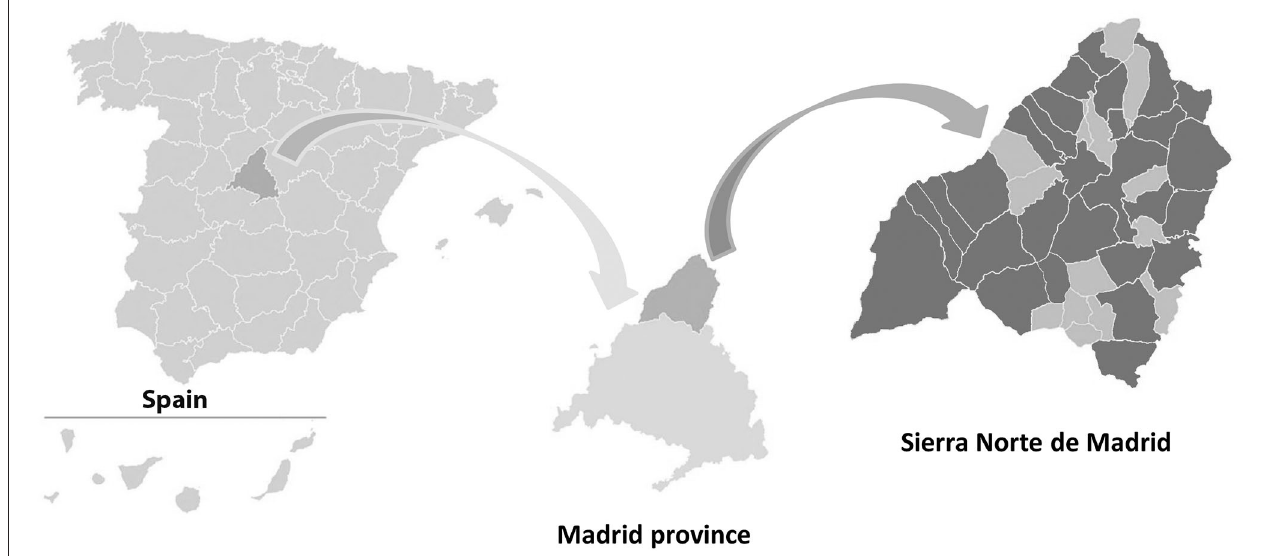
FIGURE 1 | Map of the study site showing the studied localities in dark gray (right map). Based on Aceituno-Mata et al.